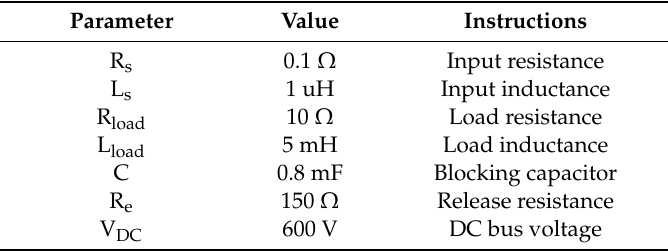
Table 4. Simulation parameters.